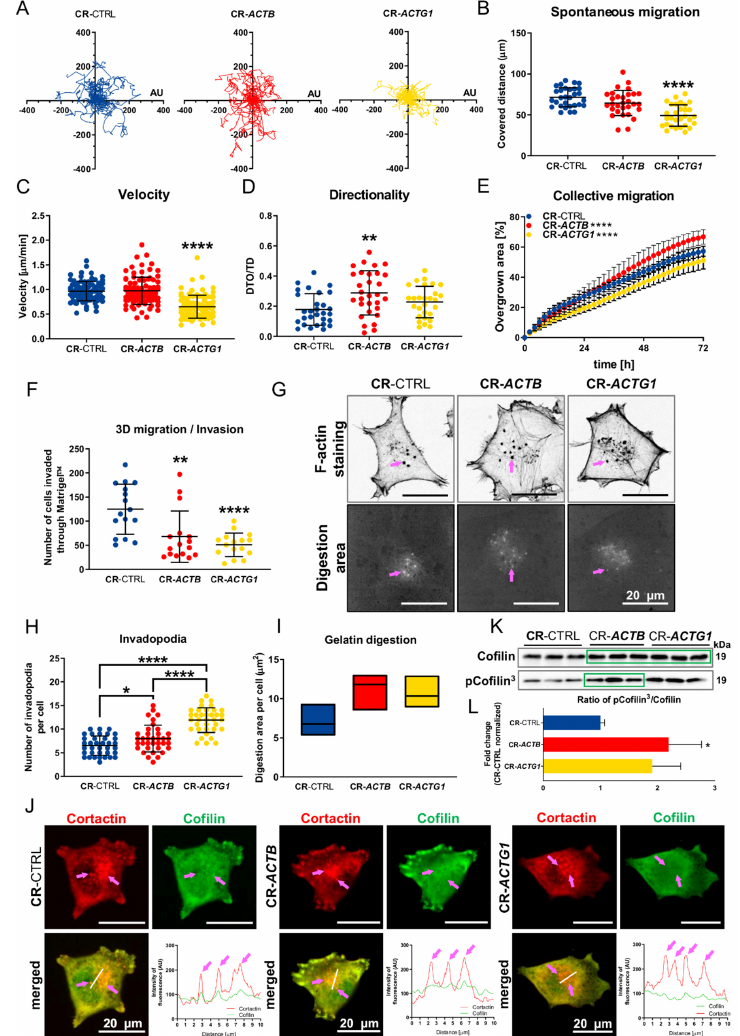
Figure 3. Cells devoid of β or γ actin had impaired invasion abilities, but only CR- ACTG1 cells’ 2-D migration was a ff ected. ( A – D ) Spontaneous 2-D migration of tested cells. The cells of studied clones growing on IncuCyte ® ImageLock plates were recorded over 72 h with IncuCyte ® Live Cell Analysis Imaging System ( n = 30). ( A ) Trajectories of single cells’ migration. ( B ) Calculated covered distances of the cells. ( C ) Estimation of velocity and ( D ) directionality of cells’ migration. ( E ) Wound healing assay was performed on control (CR-CTRL), CR- ACTB, and CR- ACTG1 cells to analyze collective migration over 72 h ( n = 3). ( F ) Analysis of 3-D migration / invasion of control cells and cells without β or γ actin ( n = 16). The cells were seeded onto Matrigel ™ gel placed in the upper compartment of a Transwell ™ and to the lower compartment a medium enriched in serum was added. ( G ) Gelatin digestion assay. The cells seeded on fluorescently labeled gelatin were 12 h later fixed and stained with Alexa Fluor ™ 488 phalloidin. Bright spots represent digested gelatin by cells. Pink arrows point at invadopodia. ( H ) Quantitative analysis of invadopodia number and ( I ) dimensions of digested area ( n = 36). ( J ) Cells after fixation were stained with antibodies recognizing cofilin and cortactin. Across the area rich in invadopodia a line was drawn and intensities of fluorescence for detected cortactin and cofilin were plotted on corresponding graphs. Pink arrows point at invadopodia. ( K ) Western blot analysis of cell lysates. Membranes were probed with antibodies detecting cofilin and cofilin phosphorylated at Ser3 (p-cofilin 3 ). Corresponding densitometric analysis and Ponceau S stainings of membranes are shown in Figure S8. Forty µ g of protein was loaded on every lane. Green rectangles represent statistically higher level of protein in comparison to control cells. ( L ) Calculated p-cofilin 3 :cofilin ratio ( n = 3). Results are expressed as the mean ± SD ( B – F , H , K ) or median ( I ), p ≤ 0.05 (*), p ≤ 0.01 (**), p ≤ 0.0001